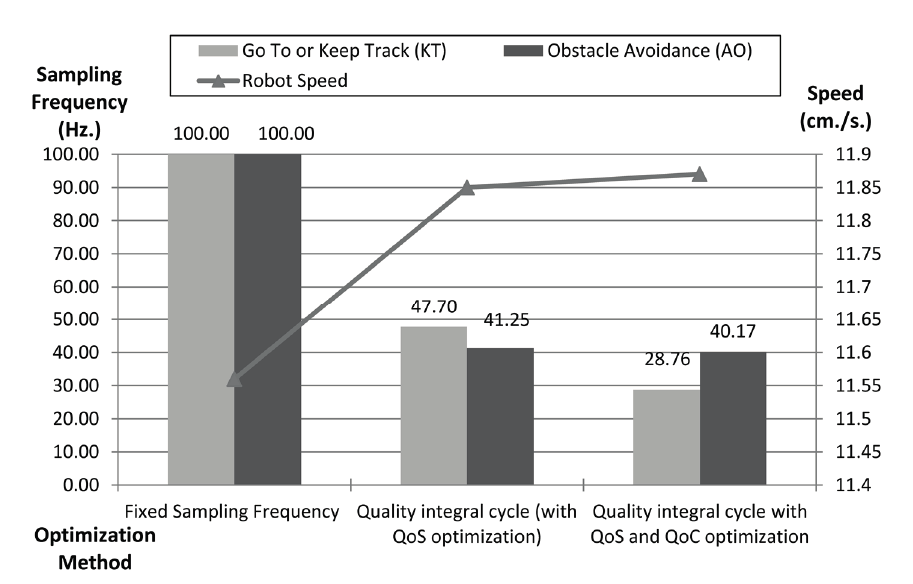
Figure 30. Optimization obtained by the dynamic management of communications and